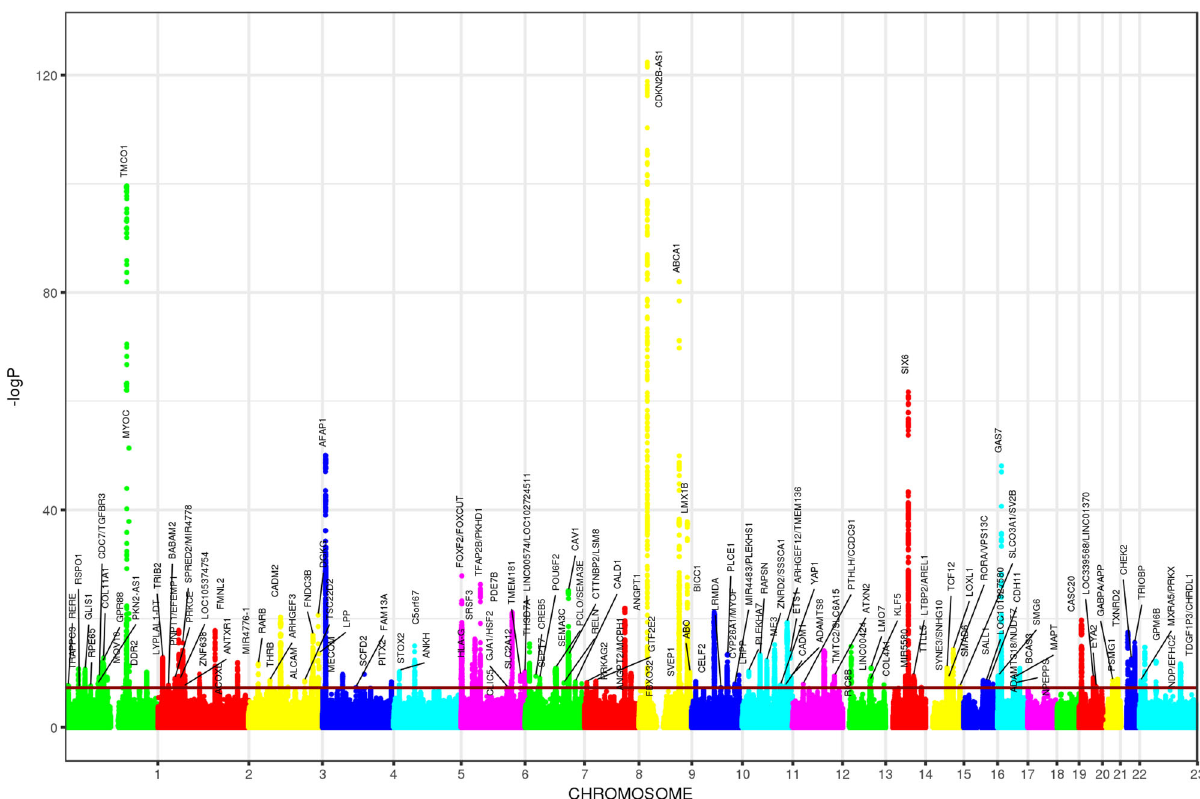
Fig. 3 Manhattan plots for the cross-ancestry meta-analysis. Each dot represents a SNP, the x -axis shows the chromosomes where each SNP is located, and the y -axis shows − log10 P -value of the association of each SNP with POAG in the cross-ancestry meta-analysis (34,179 cases vs. 349,321 controls). The red horizontal line shows the genome-wide signi fi cant threshold ( P -value = 5e-8; − log10 P -value = 7.30). The nearest gene to the most signi fi cant SNP in each locus has been